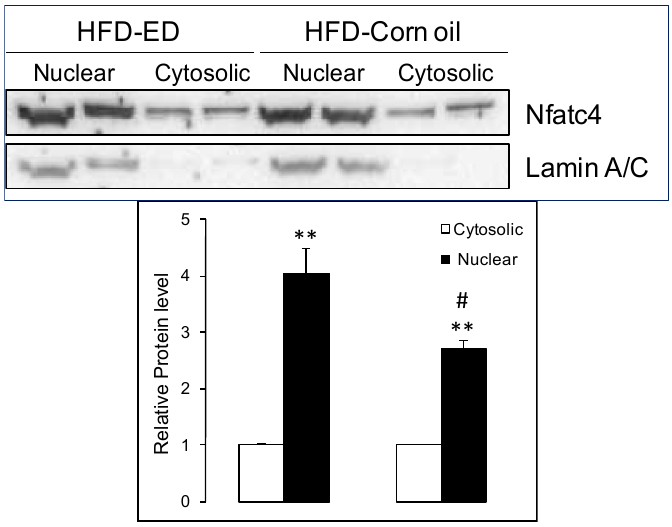
Figure 3. Representative Western blot is shown with LaminA/C loading control. Nuclear (black bars) and cytosolic (white bars) protein extract from the gSkM of HFD ‐ ED (left ‐ panel) and HFD ‐ corn oil (right ‐ panel) were analyzed by Western blot using antibodies for total anti ‐ Nfatc4 antibody and the cytosolic protein levels in the HFD ‐ ED was kept to 1. Different at ** p < 0.05 and # p < 0.01.